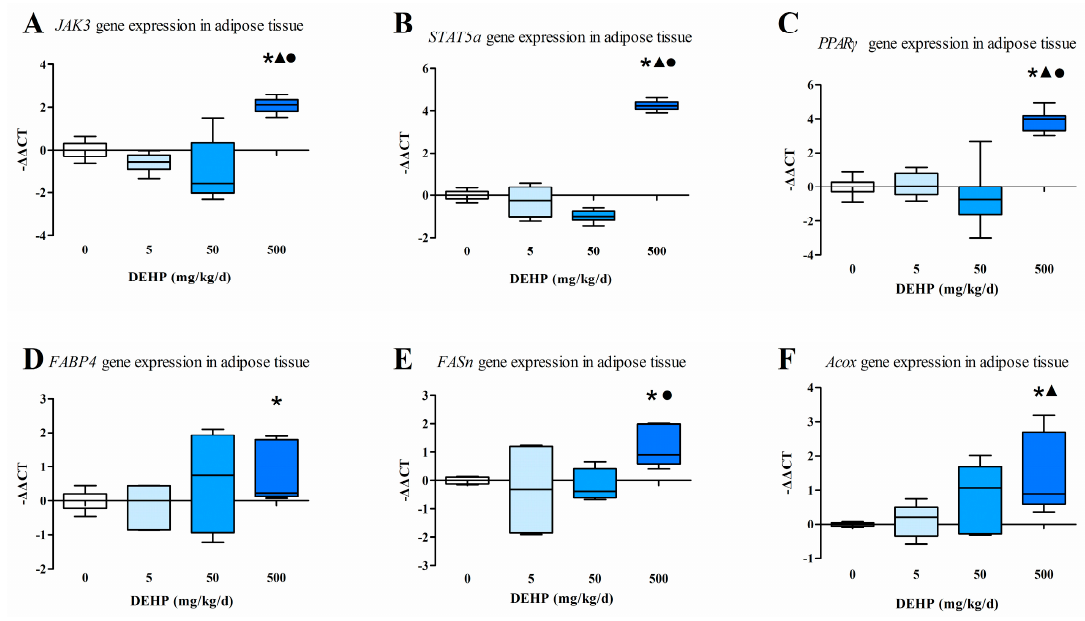
Figure 3. Effects of DEHP on expression of the JAK3/STAT5 pathway genes in adipose tissue ( n = 20 animals/ each group): ( A ) The fold change of mRNA levels of JAK3 ; ( B ) The fold change of mRNA levels of STAT5a ; ( C ) The fold change of mRNA levels of PPAR γ ; ( D ) The fold change of mRNA levels of FABP4 ; ( E ) The fold change of mRNA levels of FASn ; ( F ) The fold change of mRNA levels of Acox . All data was expressed as the min to max and the median. ● Statistically signi fi cant di ff erence compared with 50 mg·kg − 1 ·d − 1 ( p < 0.05); ▲ Statistically significant difference compared with 5 mg·kg − 1 ·d − 1 ( p < 0.05); * Statistically significant difference compared with control ( p < 0.05).